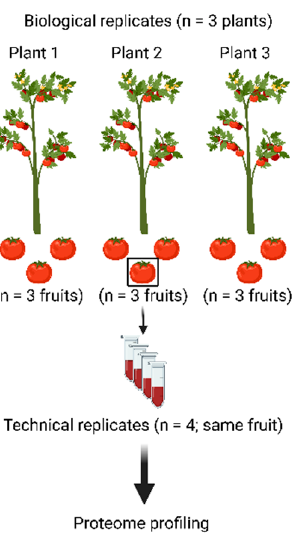
Figure 2. Experimental design to assess the merits of the proteomic workflow. Nine tomato fruits were harvested from three different plants and all were processed using the workflow depicted in Figure 1. This way, the biological variation from fruit to fruit and from plant to plant can be separated from the technical variation of the workflow, which was assessed by subjecting one tomato fruit to the complete workflow in four technical replicates.